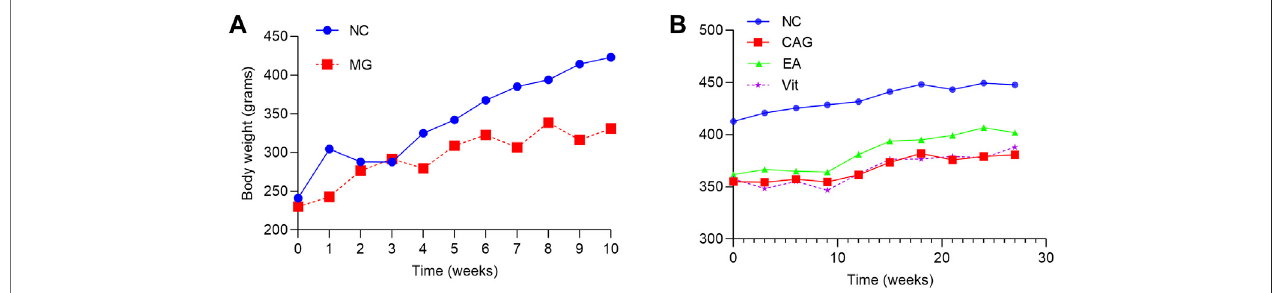
FIGURE 1 | Changes in body weight of rats in each group. (A) Change in body weight of the two groups of rats during the modeling period. (B) Change in body weight of each group of rats during the intervention phase.